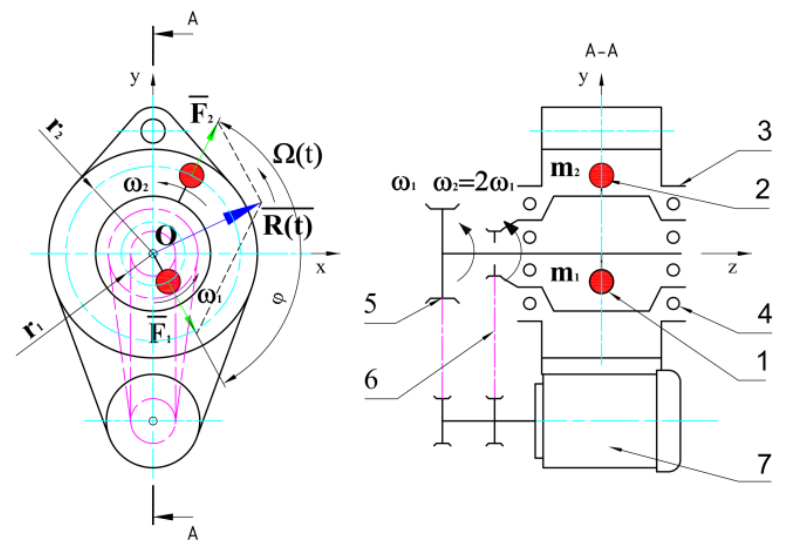
Figure 2. Kinematic diagram of the inertial vibration exciter with a single asynchronous electric motor, as follows: 1, 2 — internal and external unbalanced rotors, respectively; 3 —exciter’s body; 4— bearings; 5, 6 — belt transmissions; 7 — electric